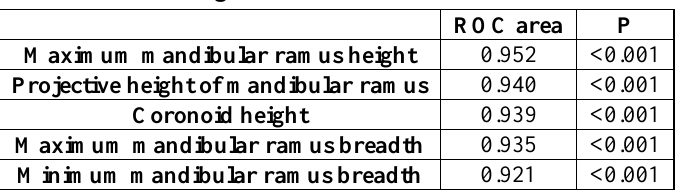
Table 4:ROC area for unilateral linear mandibular ramus measurements when used as test